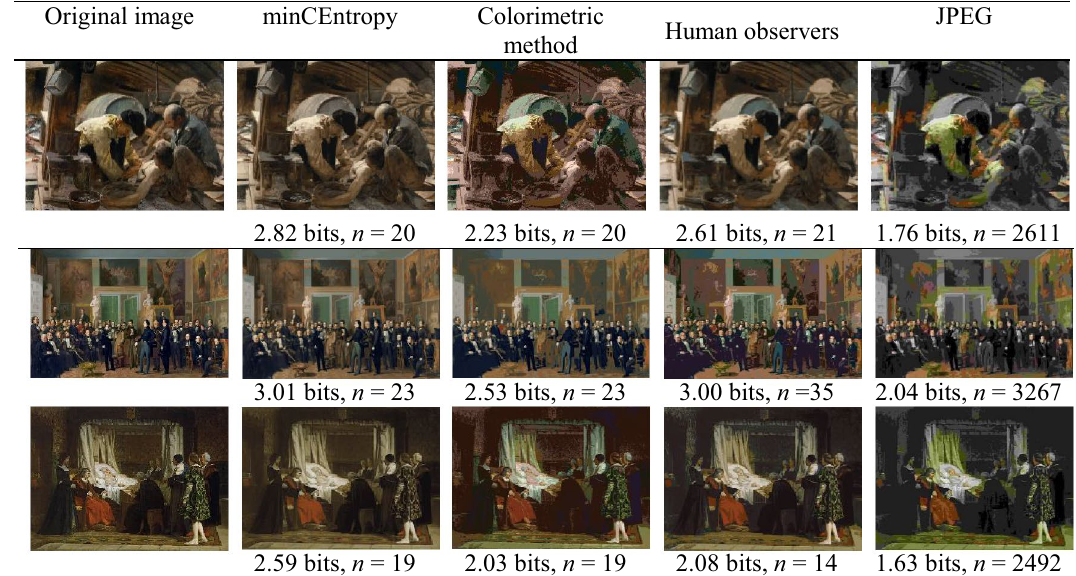
Table 3. Quantized representations of an image by relevant colors and JPEG compression. The original image from Fig. 1 is shown in the first column. Subsequent columns show the image quantized by relevant colors estimated by the minCEntropy method, the colorimetric method, a human observer, and JPEG with the fewest colors. The estimated mutual information in bits and number of relevant colors n are shown beneath the corresponding image.